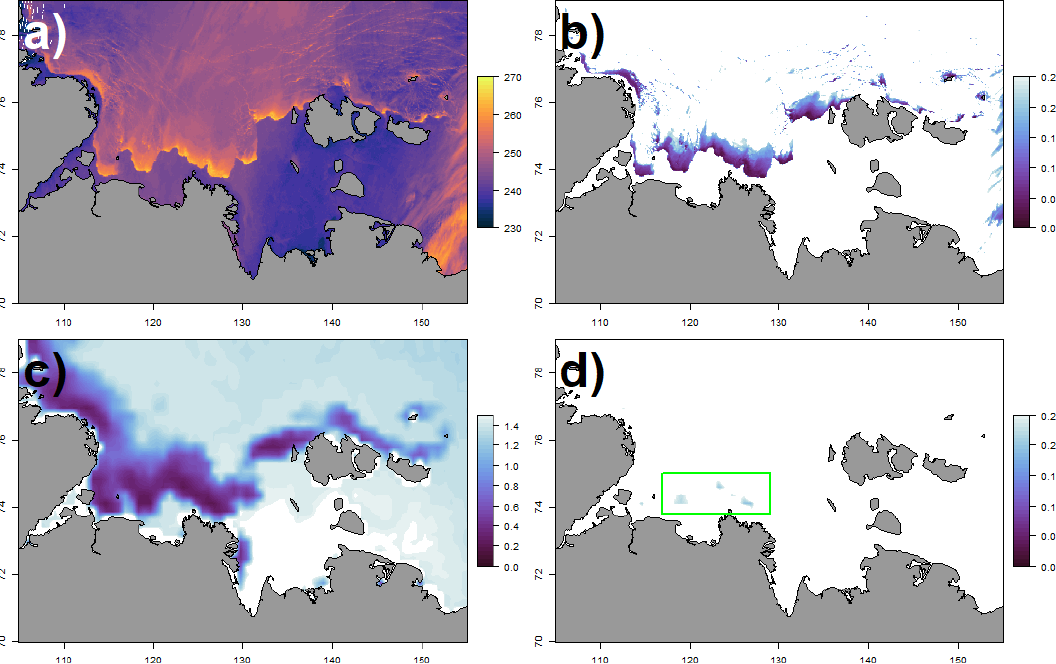
Figure A1. MODIS ice-surface temperature ( IST in K; a) and its associated thin-ice thickness ( TIT; b) between 0 and 0.25m and SMOS sea-ice thickness (Tian-Kunze et al., 2014) between 0 and 1.5m (c) as well as between 0 and 0.25m (d) , respectively. A green rectangle highlights the remaining thin-ice areas in (d) . Image data acquired on 5 March 2011 as shown in Fig. 3 with a different colour map.